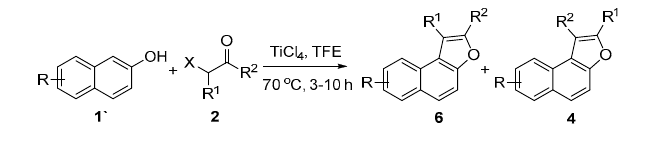
Table 2. Reaction of naphthols with different acyclic α -haloketones a, b, c .